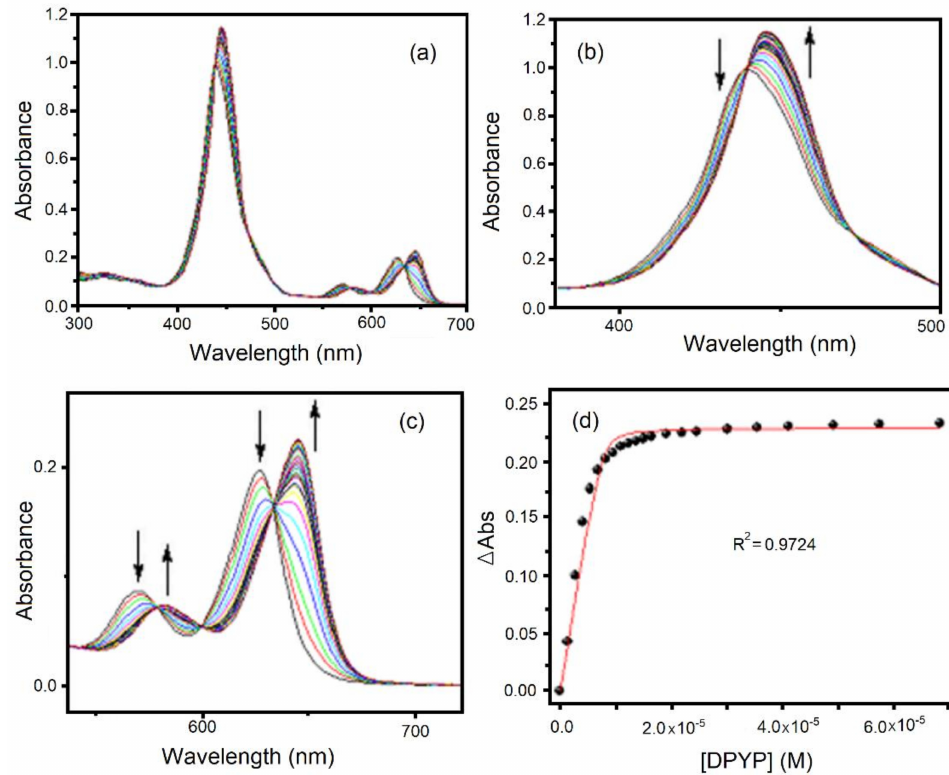
Figure 3. UV-vis titration spectra of Zn-trisporphyrin 1 with DPYP in toluene ( c = 1 µ M). ( a ) UV- visible region, ( b ) Soret-band zone, ( c ) Q-band zone, ( d ) fitting curve for the determination of the binding constant K 32 at 446 nm.